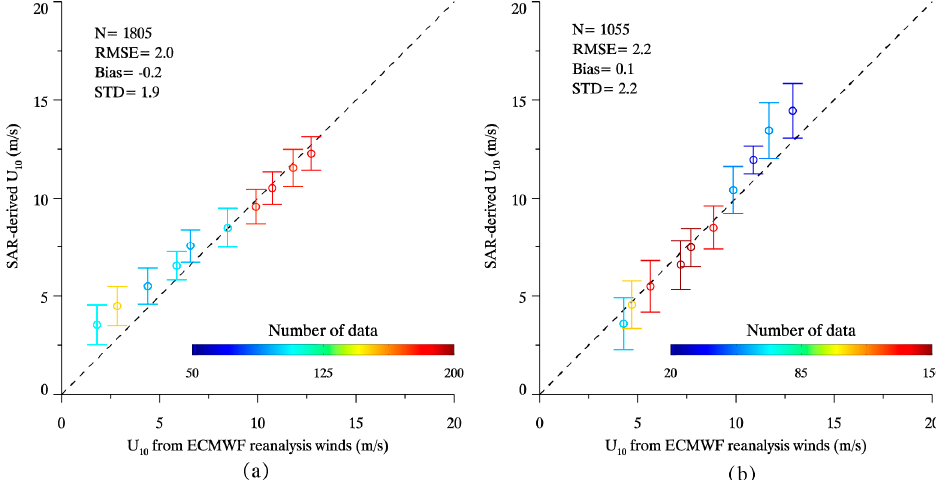
Figure 7. The comparison between SAR-derived wind speed U 10 and ECMWF re-analysis gridded winds at 1 m/s bins. ( a ) Comparison for 96 VV-polarization GF-3 SAR images; and ( b ) Comparison for 70 HH-polarization GF-3 SAR images.